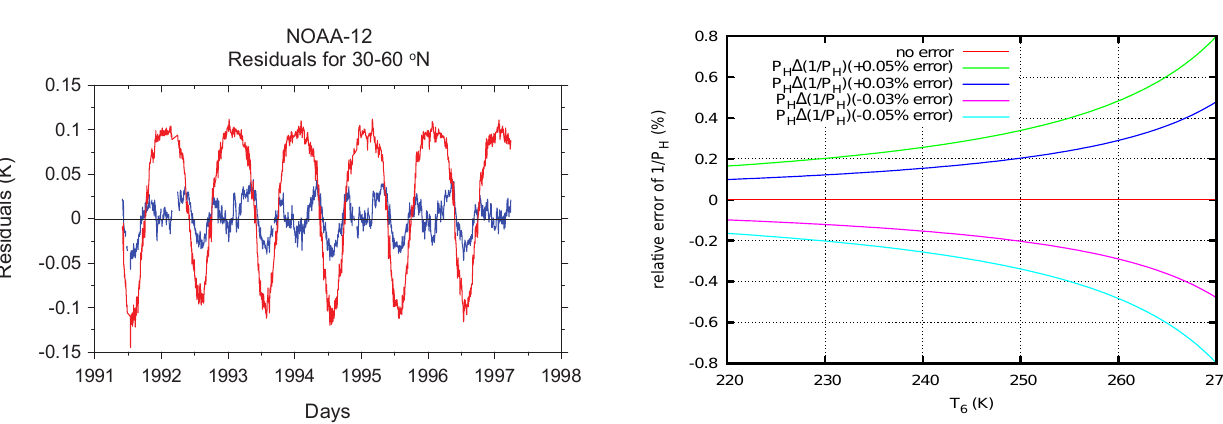
Figure 1. Residuals T 6 / 2 − ˆ T 6 / 2 (blue curve) and T 6 / 2 − T 6 / 4 (red Fig. 1. Residuals T 6 / 2 − ˆ T 6 / 2 (blue curve) and T 6 / 2 − T 6 / 4 (red curve) averaged over the indicated latitude band and for each day of curve) averaged over the indicated latitude band and for each day of NOAA-12 operation. NOAA-12 operation.